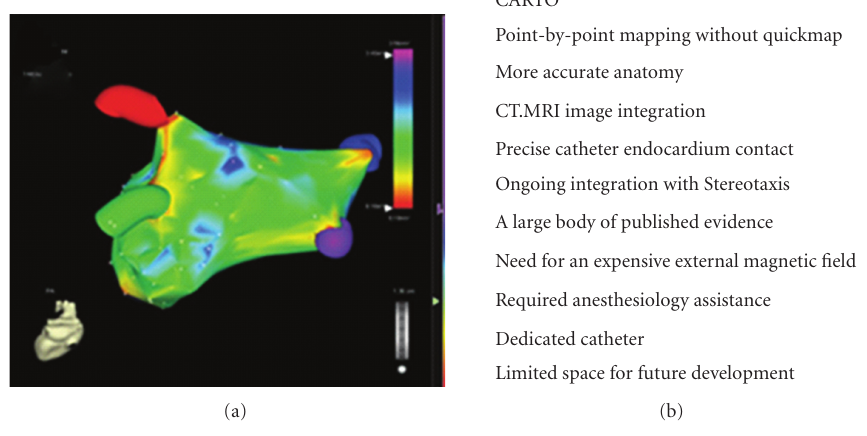
Figure 1: (a) Preablation colour-coded 3D maps using the CARTO electroanatomic guidance systems shown in the postero-anterior anatomic view. (b) Advantages and disadvantages of CARTO (taken from